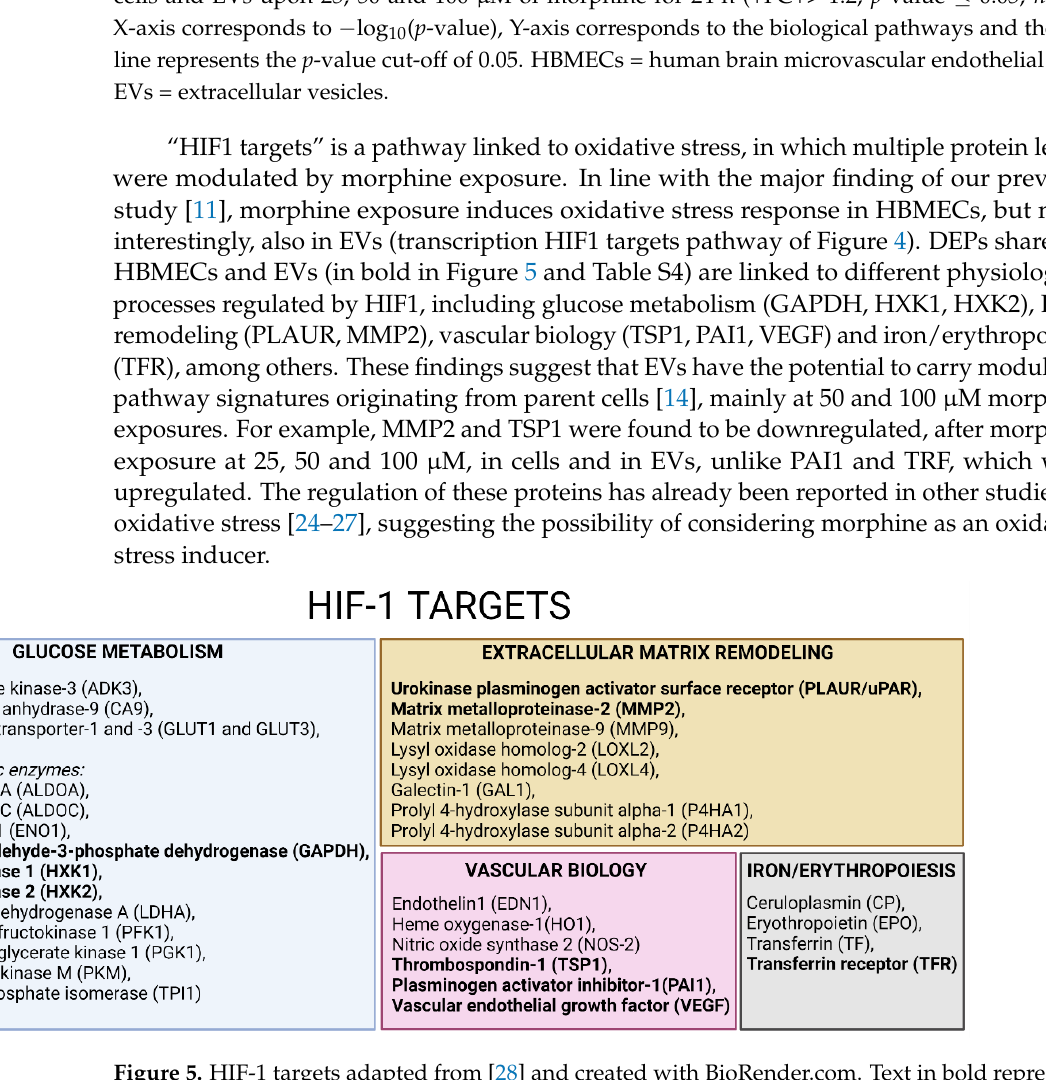
Figure 5. HIF-1 targets adapted from [28] and created with BioRender.com. Text in bold represents DEPs found in HBMECs and EVs upon various morphine concentrations.